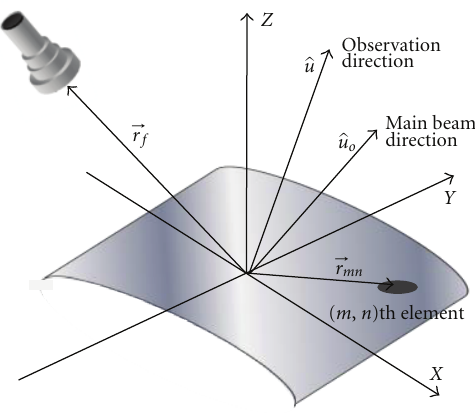
Figure 1: Coordinate system of the reflectarray